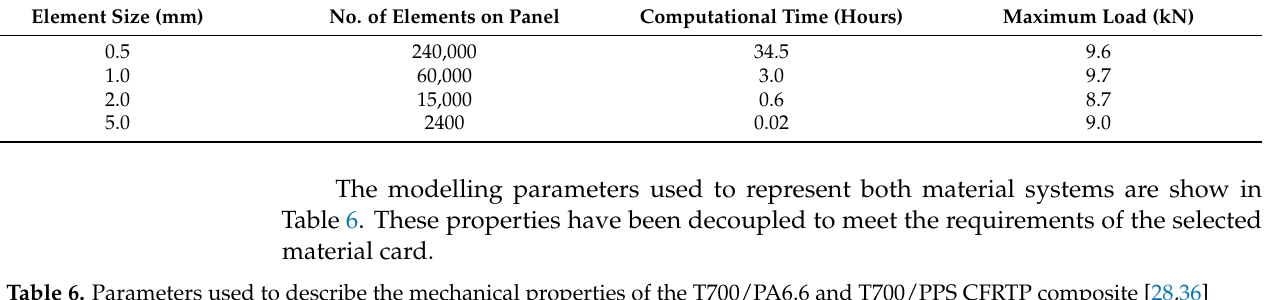
Table 6. Parameters used to describe the mechanical properties of the T700/PA6.6 and T700/PPS CFRTP composite [28,36] and the contact